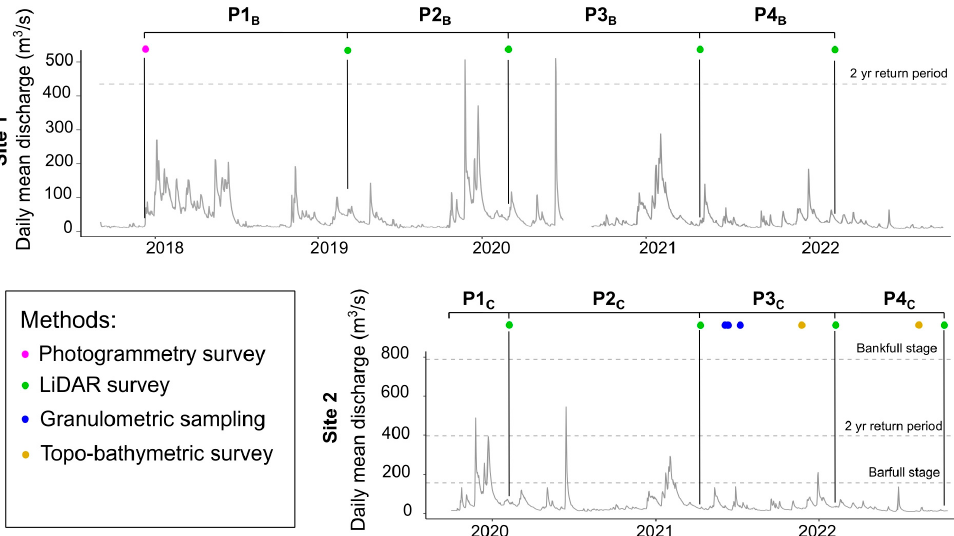
Figure 2. Daily mean discharges of the Allier River at the Vic-le-Comte gauging station (Site 1) between September 2017 and October 2022 in the top graph (“https://hydro.eaufrance.fr (accessed on 15 February 2023)”). Daily mean discharges at the Limons gauging station (Site 2) between September 2019 and October 2022 in the bottom graph (“https://hydro.eaufrance.fr (accessed on 15 February 2023)”). The calendar of the different surveys carried out is represented by coloured dots. The hydrological series is divided into four periods (from P1 B to P4 B for Site 1 and from P1 C to P4 C for Site 2) according to the date of the LiDAR surveys. See the Methods section for the different methods employed.